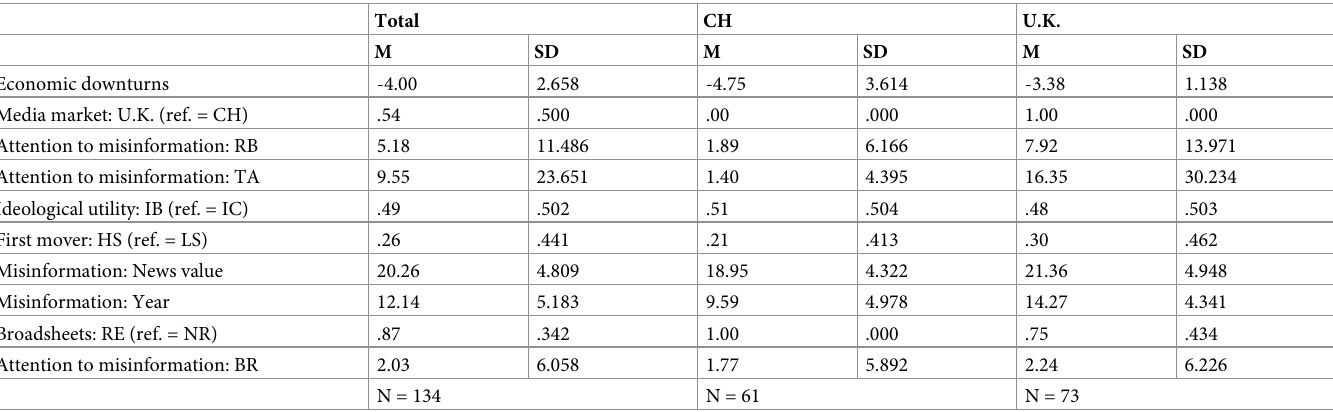
Table 2. Descriptive statistics (business